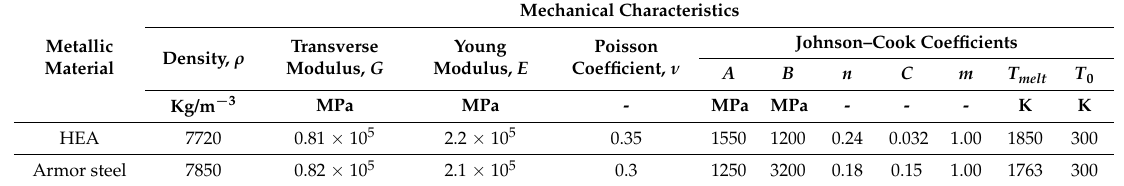
Table 3. Johnson–Cook model.